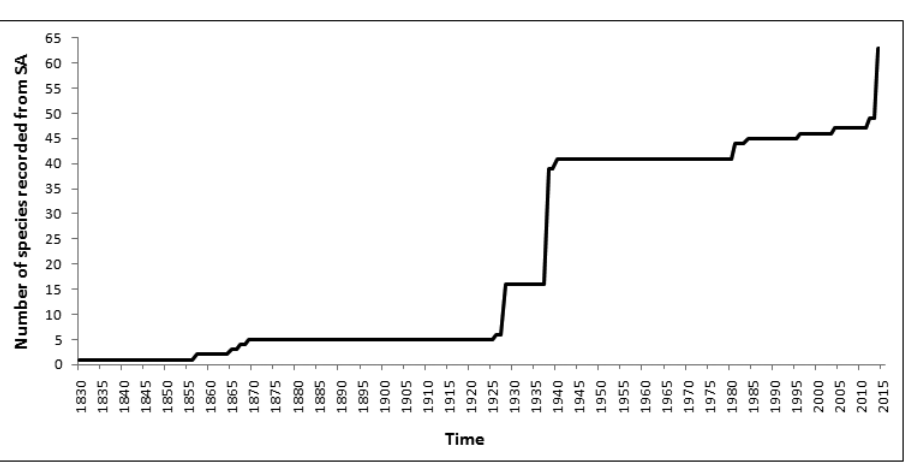
Figure 2. The number of species recorded from South Africa between 1830 and